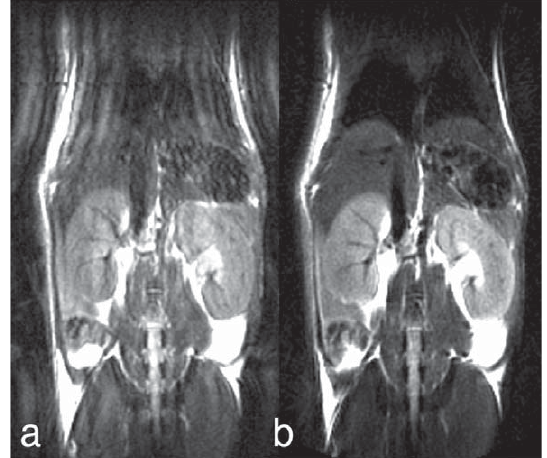
Fig.7. Effectsofmotion(ringingaroundsharpedges)canbegreatly decreased relative to Cartesian Fast Spin Echo (a) using PRO- PELLER (b) imaging These images were acquired on a 7T magnet at 195 × 195 (cid:1) m resolution in plane, 1mm slices, TR=3s, echo spacing 5ms, echo train length 24 (lines per blade), in ∼